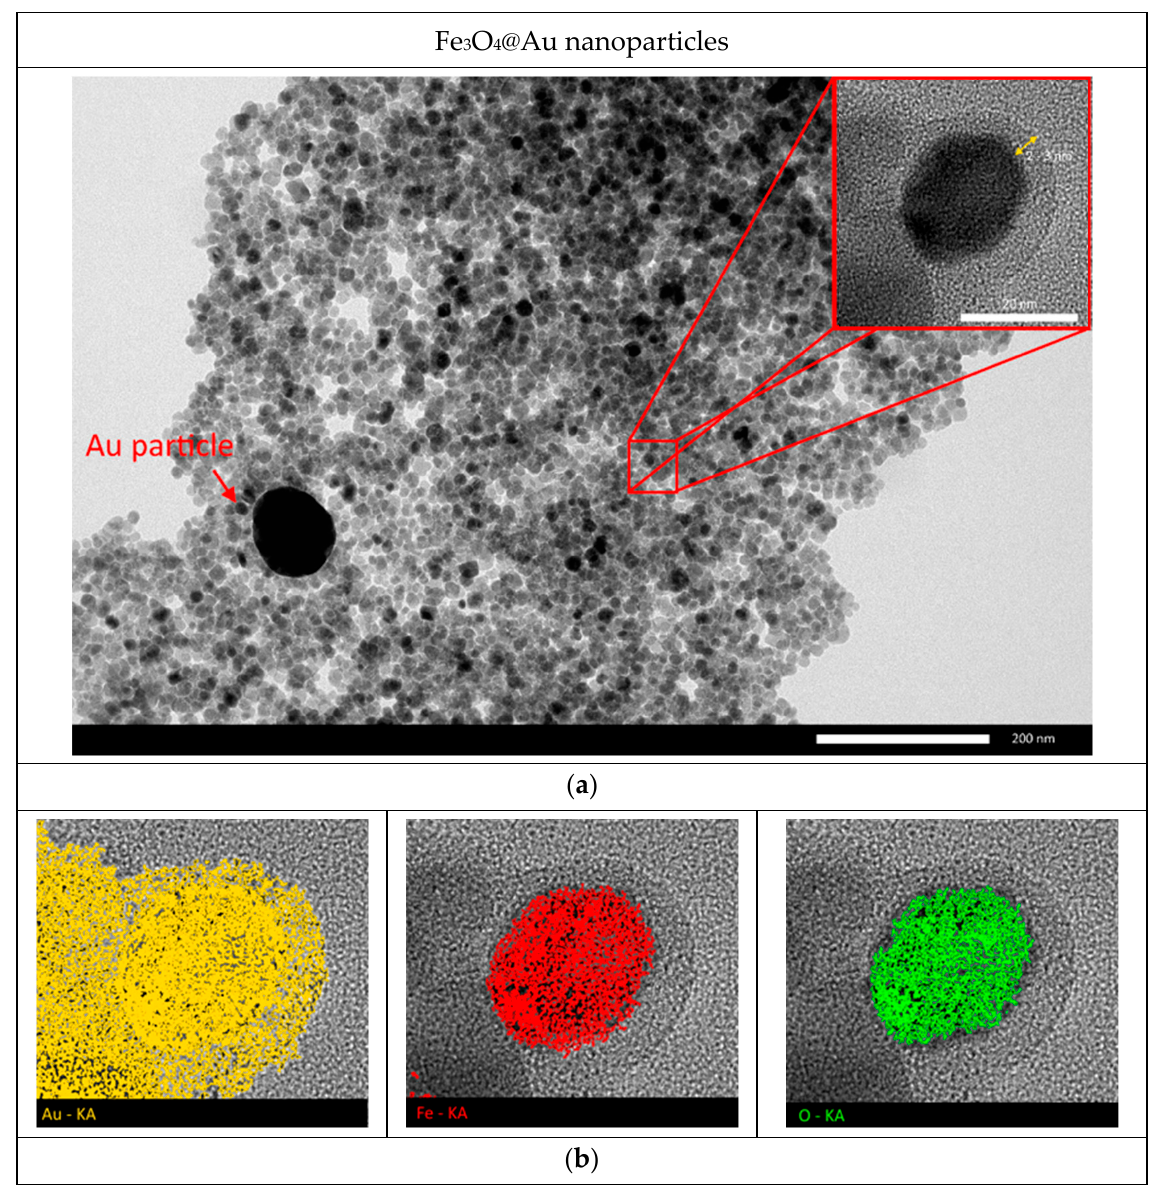
Figure 4. ( a ) TEM image of Fe 3 O 4 @Au nanoparticles (inset shows high-resolution TEM image of Fe 3 O 4 @Au nanoparticles); ( b ) mapping results of Fe 3 O 4 @Au nanoparticles.